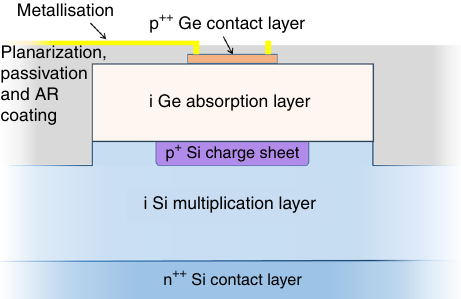
Fig. 1 Ge-on-Si single-photon avalanche diode (SPAD) structure. Cross- section of a planar Ge-on-Si SPAD showing the Ge top contact and absorption layers, the Si charge sheet, multiplication and bottom contact layers, metallisation and the planarization, passivation and anti-re fl ection